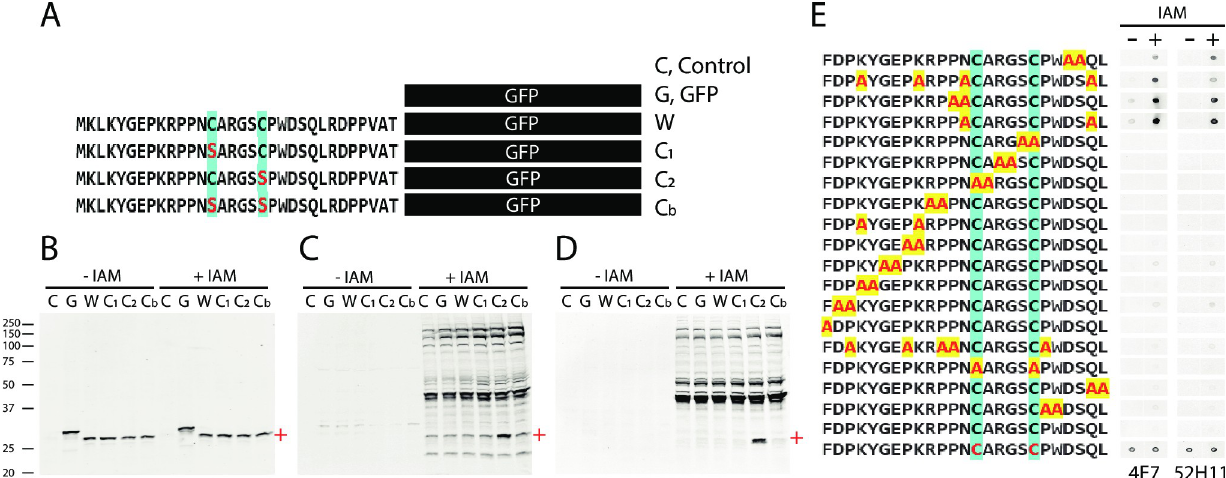
Fig 7. Peptide sequences targeted by 4E7 and 52H11. (A) Schematic of sequences fused to GFP in cDNA expression constructs. Wild type human MYADML2 fragment (W) and three variants with mutations in cysteines (to serine marked in red; C1, C2, and Cb) were transfected into cells. Lysates from transfectants were incubated at 37˚C for 30 min with or without IAM (5 mM) were analyzed by GFP (B), 4E7 (C) and 52H11 (D) Western blotting. + indicates the molecular weight of peptide-fused GFP proteins. (E) a series of mutant peptides corresponding to the immunization epitope were analyzed by dot blotting. For IAM treated dots, peptides were incubated with IAM 5mM at 37˚C for 30 minutes. Each dot contains 1 μ g of each of the peptides shown, spotted on nitrocellulose.